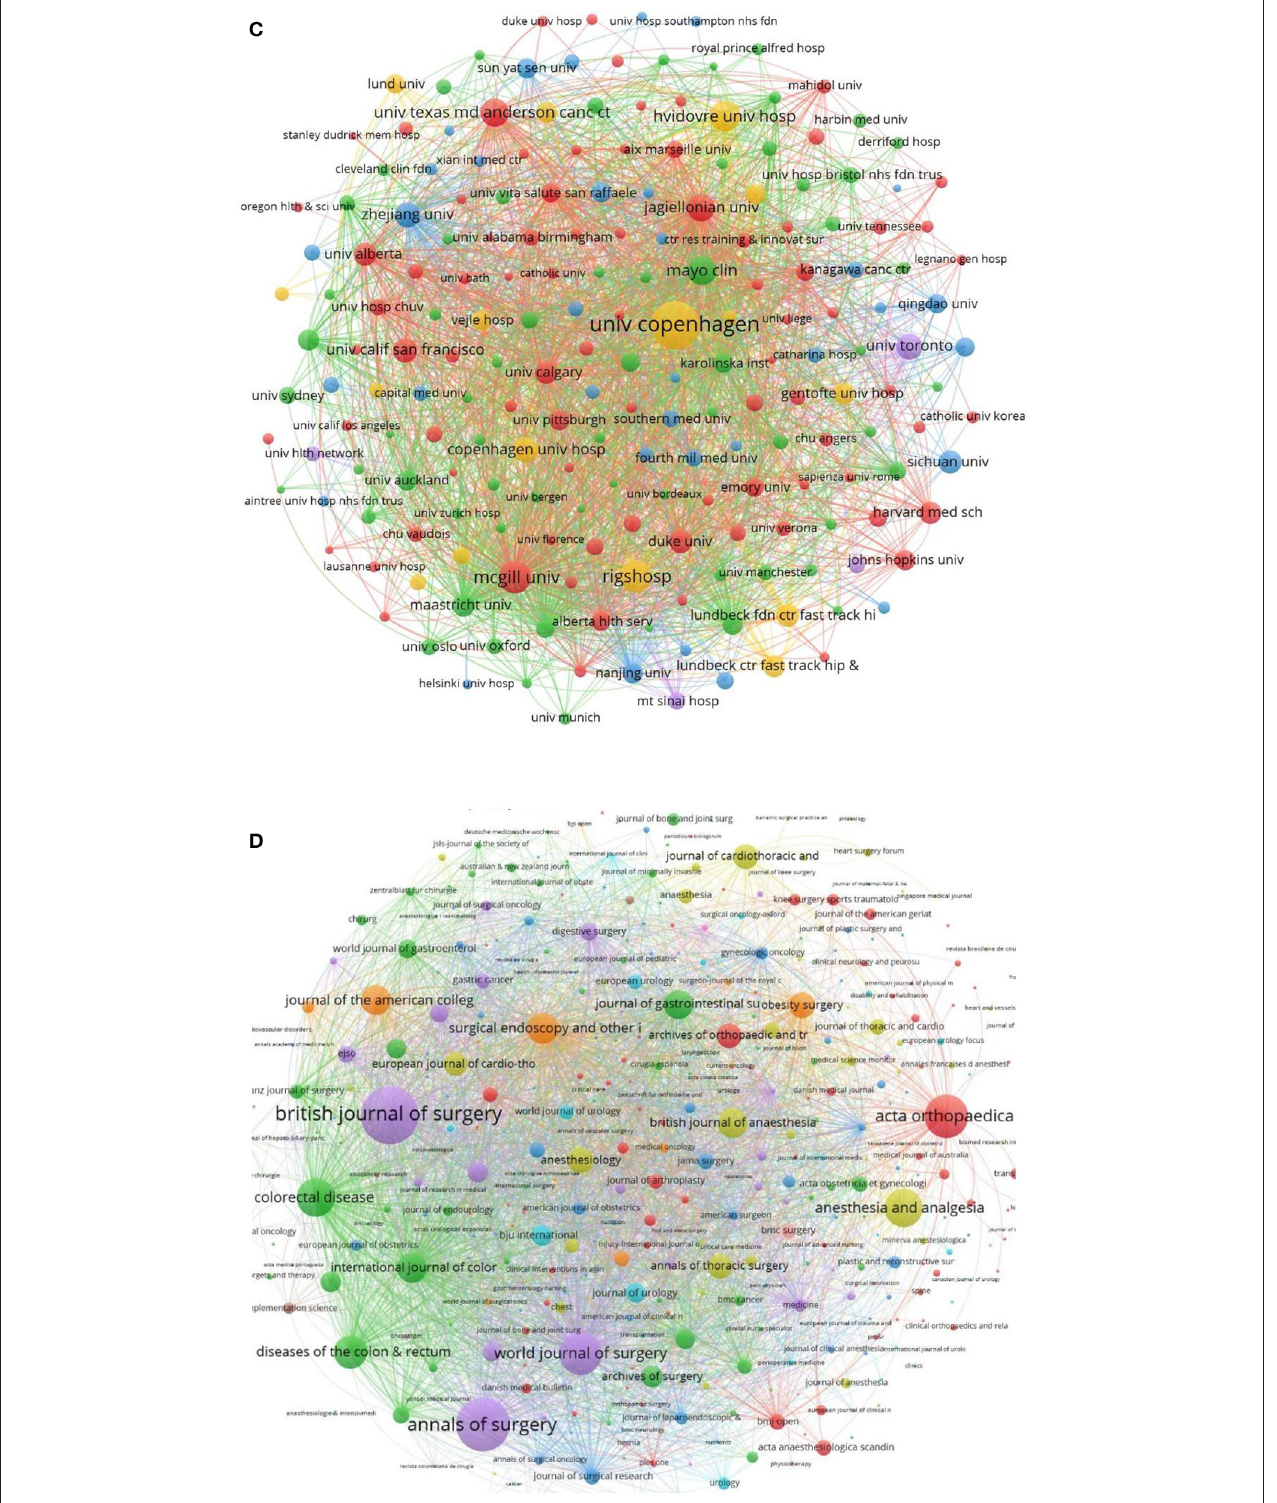
FIGURE 4 | Visualized analysis of authors, cited authors, institutions, journals. (A) Bibliographic coupling analysis of authors. (B) Co-citation analysis of cited authors. (C) Bibliographic coupling analysis of institutions. (D) Journals.